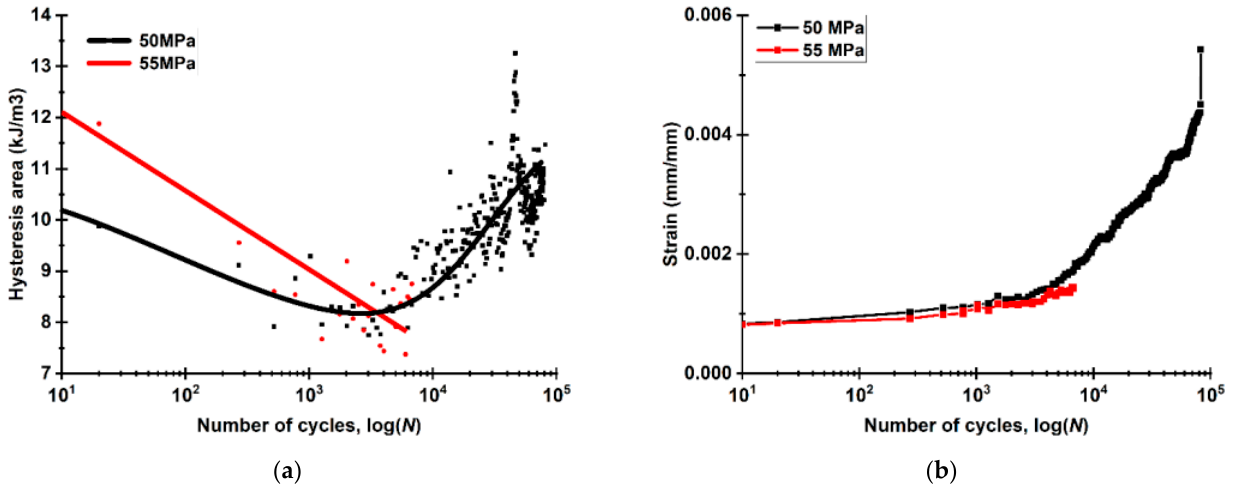
Figure 14. The strain behavior of the USW lap joints in the fatigue tests in terms of the mechanical hysteresis loop areas ( a ) and the residual strains ( b